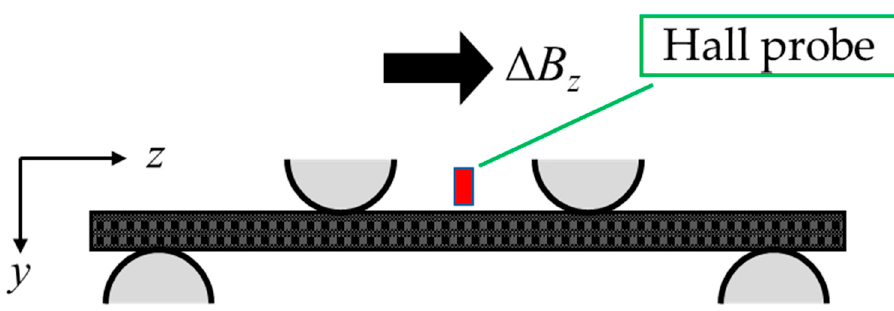
Figure 3. Location of hall probe and measurement direction.